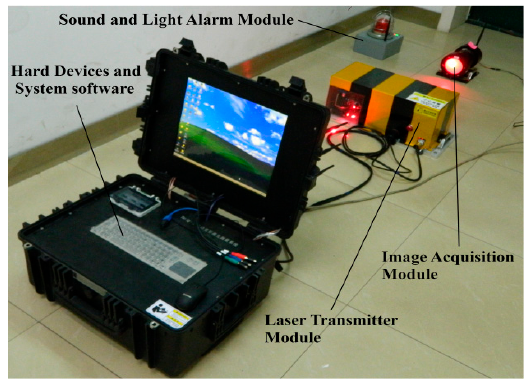
Figure 5. Main composition of the real-time tunnel deformation monitoring system.